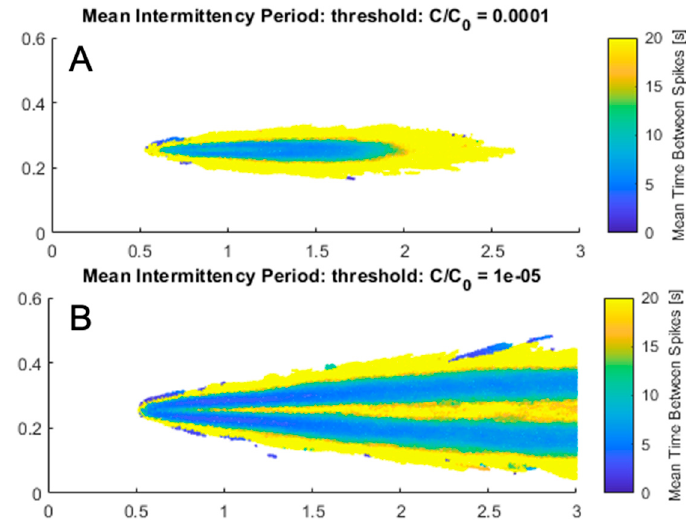
Figure 9. ( A ) Mean intermittency (s) at concentration threshold of 0.01% throughout the flume measured by time between concentration above the threshold. ( B ) Mean intermittency at concentration threshold of 0.001% throughout the flume measured by time between concentration above the